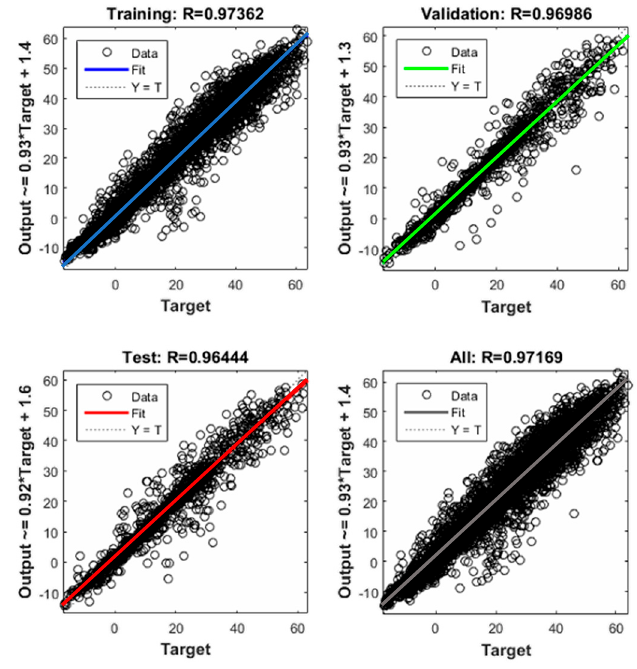
Figure 7. Regression analysis on the optimized ANN model.